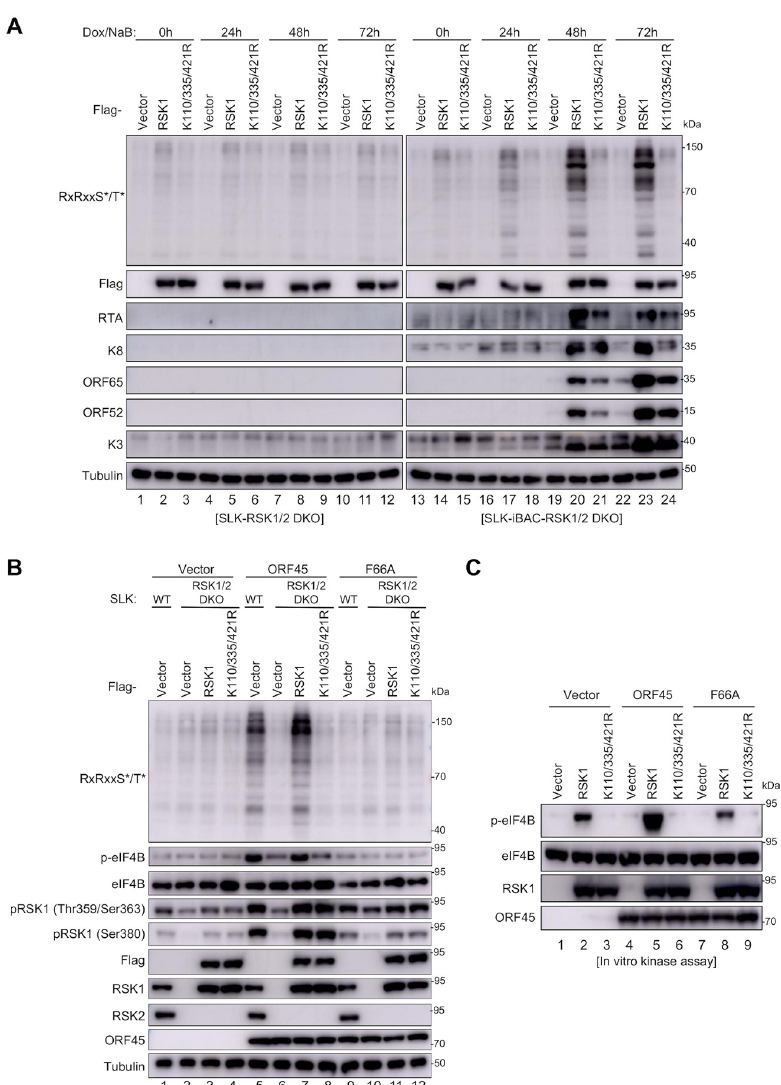
Fig 5. RSK1 SUMOylation affects the phosphorylation of its downstream substrates. ( A ) SUMOylation of RSK1 contributes to the overall phosphorylation of its substrates during KSHV lytic replication. SLK RSK1/2 DKO -vector, SLK RSK1/2 DKO -RSK1, SLK RSK1/2 DKO -RSK1 K110/335/421R , SLK-iBAC RSK1/2 DKO -vector, SLK-iBAC RSK1/2 DKO -RSK1, or SLK-iBAC RSK1/2 DKO -RSK1 K110/335/421R cells were induced with doxycycline (2 μ g/ml) and sodium butyrate (1 mM) and cell lysates were subjected to IB with indicated antibodies. ( B ) SUMOylation of RSK1 affects the overall phosphorylation of RSK1 substrates in the presence of KSHV ORF45. SLK-vector, SLK RSK1/2 DKO -vector, SLK RSK1/2 DKO -RSK1 and SLK RSK1/2 DKO -RSK1 K110/335/421R cells were infected with lentiviruses containing empty vector, ORF45 WT or ORF45 F66A as indicated. The cells were serum-starved for 24 h before sample collection and cell lysates were analyzed by IB with indicated antibodies at 48 h post-transfection. ( C ) SUMOylation site mutations affect eIF4B phosphorylation by RSK1 in vitro . RSK1 kinase complexes with or without ORF45 were purified from HEK293A cells transfected with indicated plasmid. HA-eIF4B was purified from transfected HEK293T cells by affinity purification. RSK1 (5 μ l) were mixed with eIF4B (0.5 μ g) in kinase assay buffer at 30 ˚C for 30 min. The reaction was stopped by adding 2 x SDS-PAGE loading buffer, followed by IB analysis with indicated antibodies.